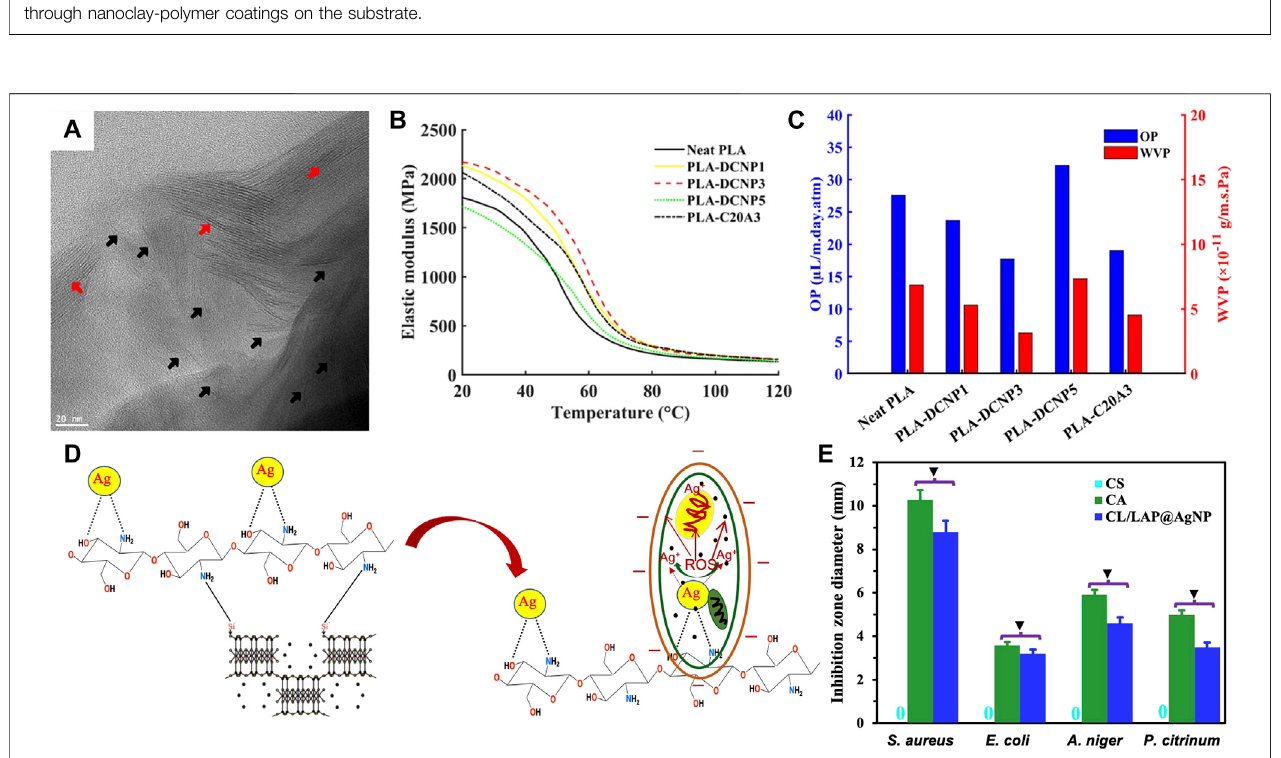
FIGURE 7 | (A) HRTEM micrograph of the nanoclay-PLA composite fi lm. Red and black arrows demonstrate the intercalated and exfoliated nanoclay platelets, respectively. (B) Storage modulus versus temperature and (C) oxygen permeability (OP) and water vapor permeability (WVP) of PLA composite fi lms with